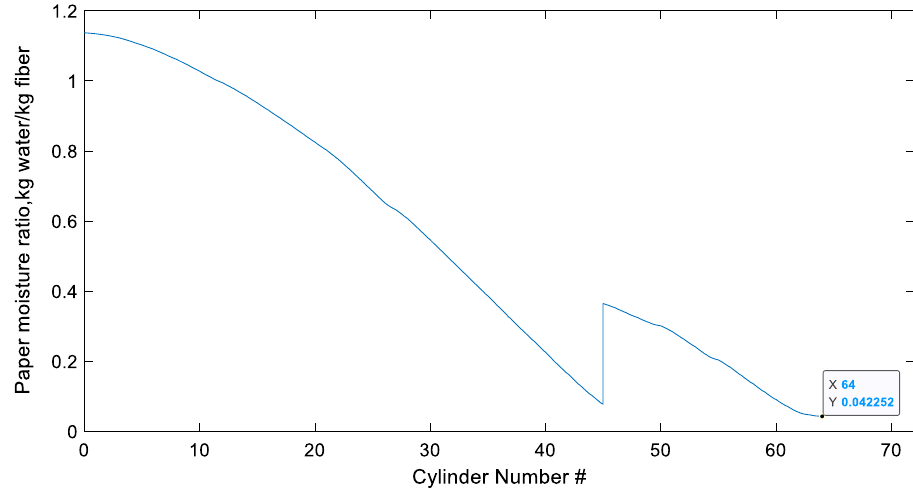
Fig. 13 Paper moisture ratio as three cylinders are added at Hex = 0.180 kg H2O/kg